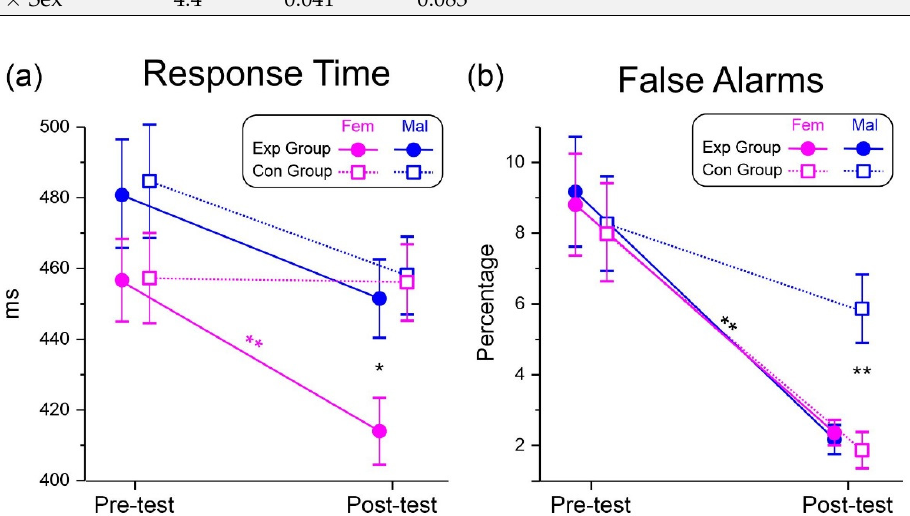
Figure 4. Behavioural results in the cognitive test. ( a ) Response time. ( b ) False alarms. Vertical bars indicate 0.95 confidence intervals. * p < 0.05, ** p < 0.01.